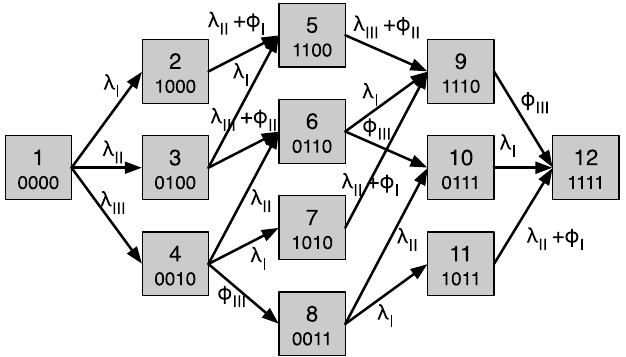
Fig 5. The state transition diagram for the tongue cancer model. Each node corresponds to a possible metastatic state and is represented by a binary string which signifies which lymph node station is positive or negative. For convenience the nodes are named from 1 to 12. The rates are obtained from the flow rates in the anatomic network (Fig 1) by considering the rate at which individual sites become positive based on the state of the other